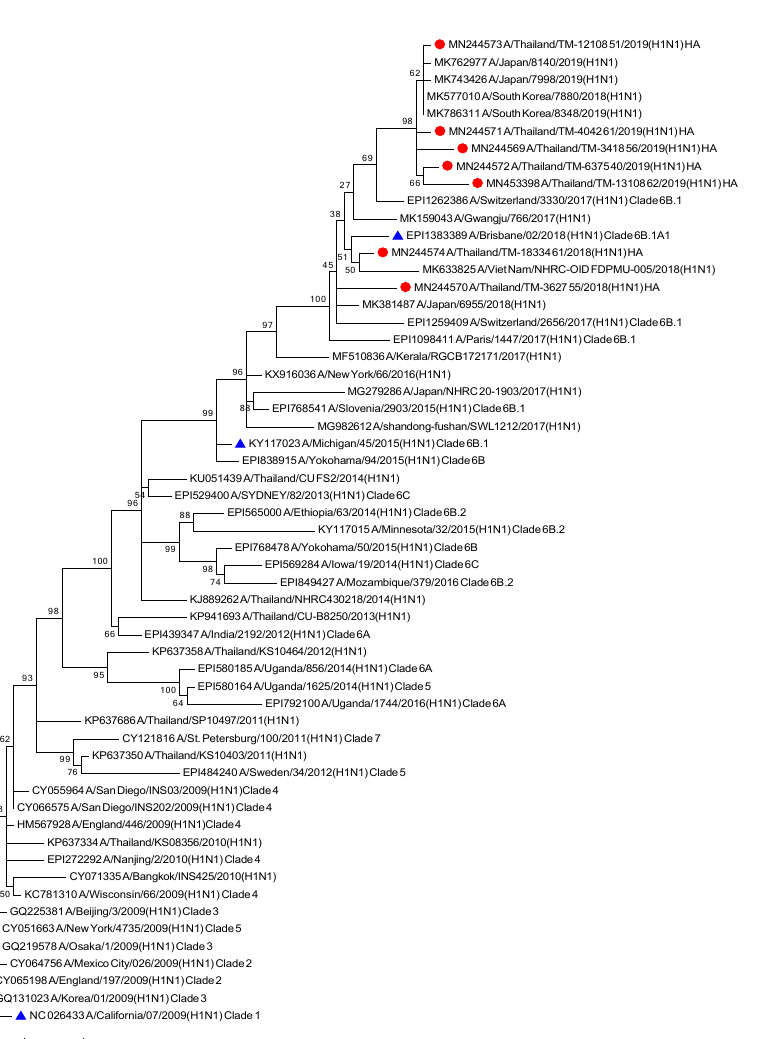
Figure 1. Phylogenetic tree of concatenate from all 8 genes of influenza A/H1N1 Thai strains was inferred by using the Maximum Likelihood method based on the Tamura 3-parameter model. Red circles indicate A/H1N1 Thai isolates and blue triangles indicate A/H1N1 vaccine strains.